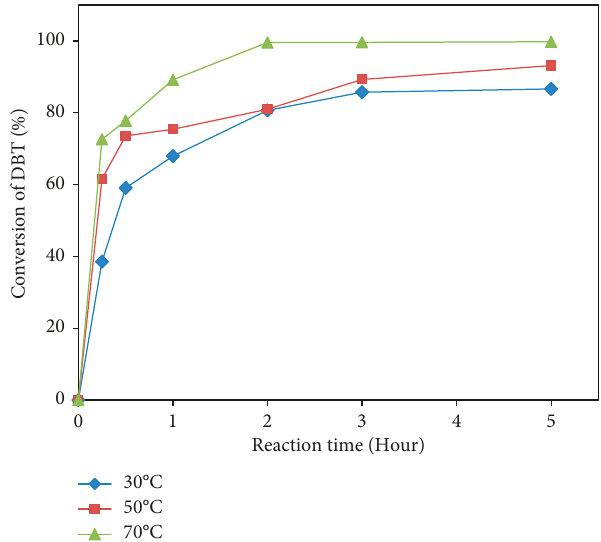
Figure 10: Conversion of DBTunder visible irradiation at various reaction temperatures. Experimental conditions: V (model fuel)